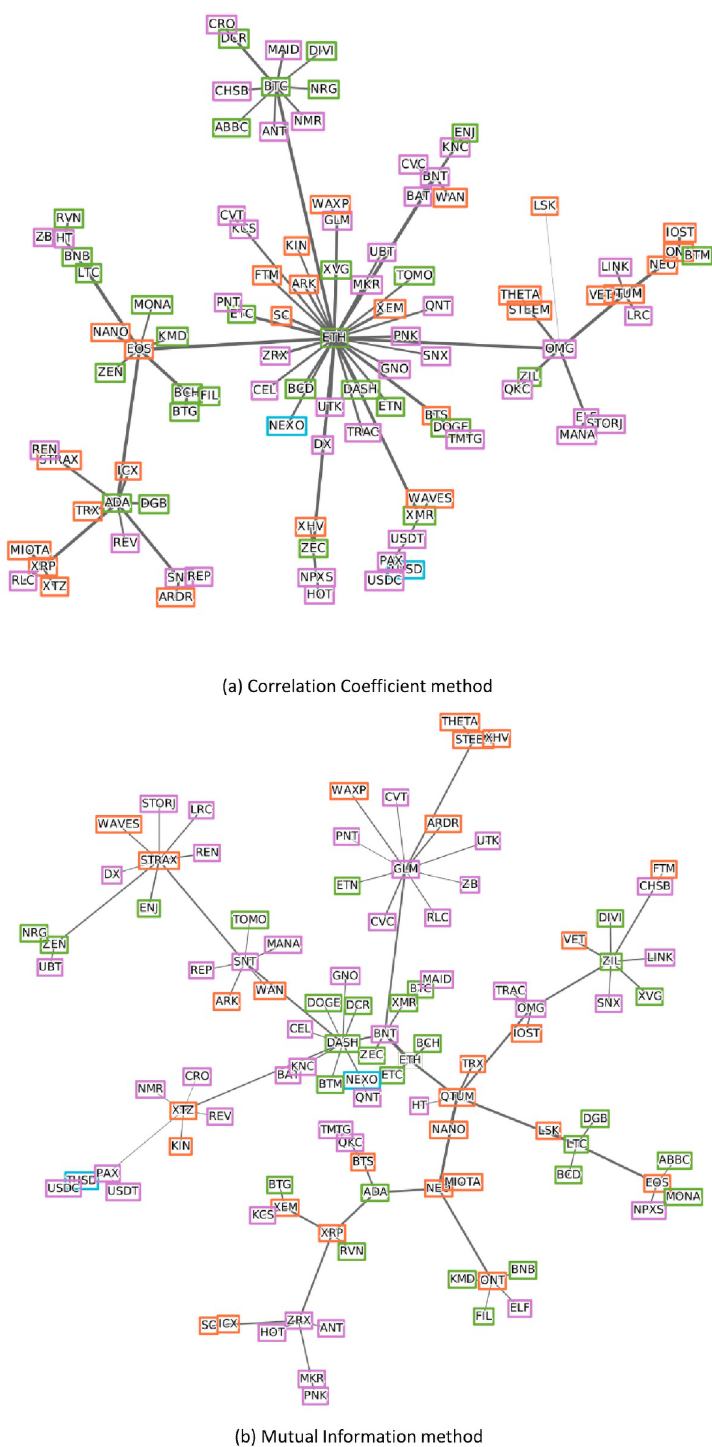
Fig 6. MST for each method in pre-COVID-19 period. Colors represent types (see Table 1) and the edge’s thickness shows inversely proportional to the distance between two nodes.